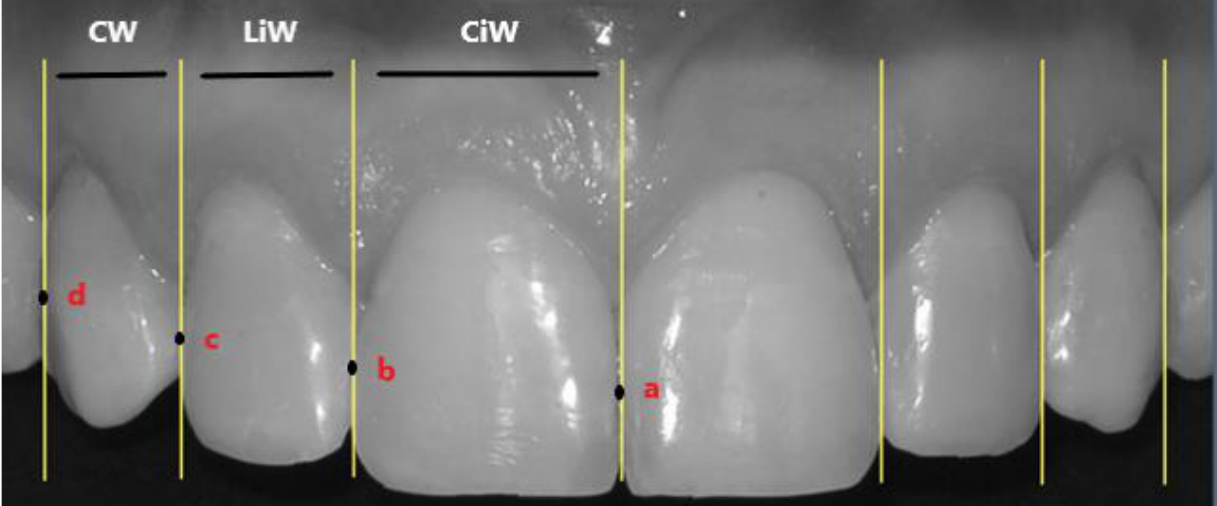
Figure 1. In this photo, the most important points for the evaluation of the studied measurements are highlighted. CiW (central incisor width) represents the value of the distance between point a and point b (that is to say, the width of the upper central incisor), LiW (lateral incisor width) represents the value of the distance between point b and point c , and CW (canine width) represents the value of the distance between point c and point d .